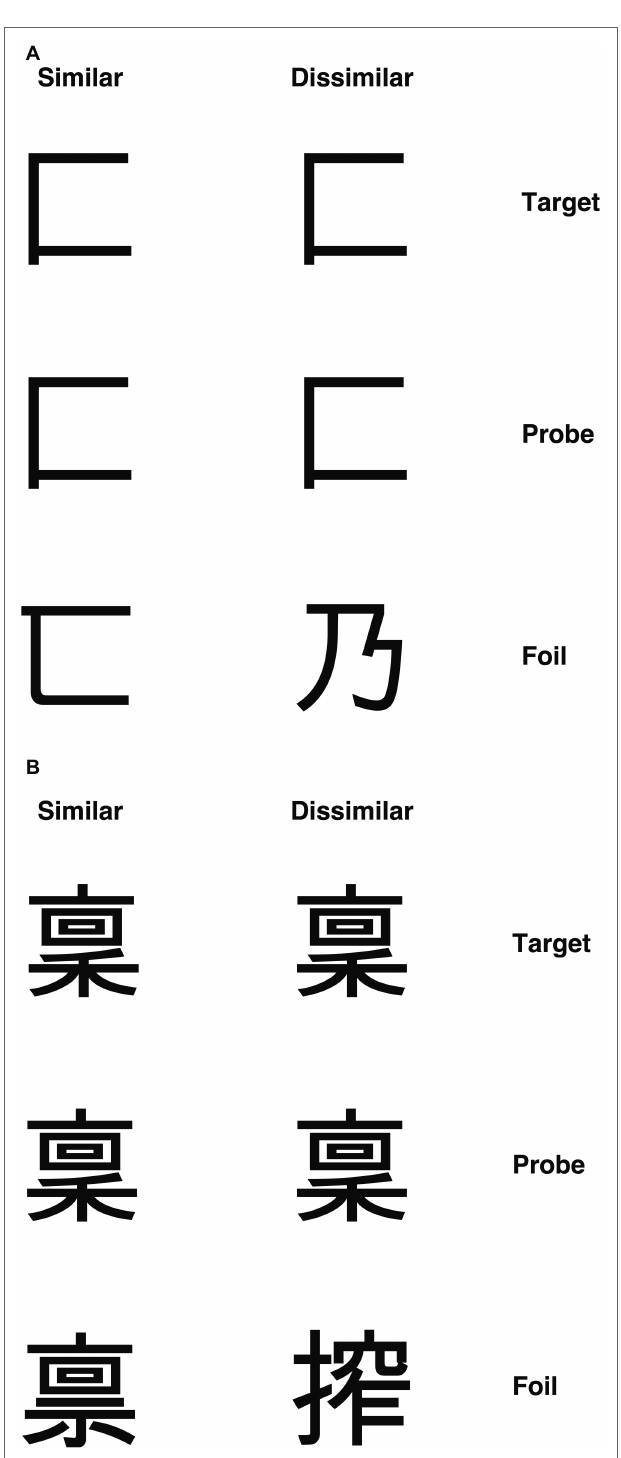
FIGURE 3 | Example checkerboard stimuli for (A) visually simple condition and (B) visually complex condition with similar and dissimilar foils (Roberts et al.,